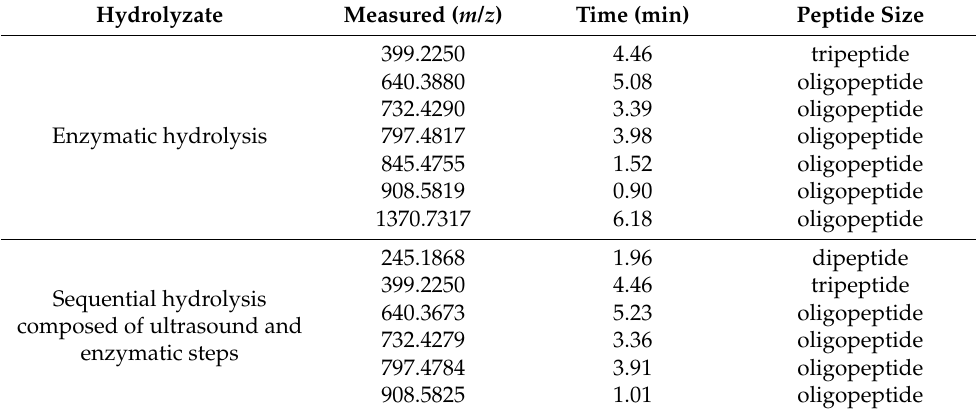
Table 7. Peptide profile of chicken feather hydrolyzates.